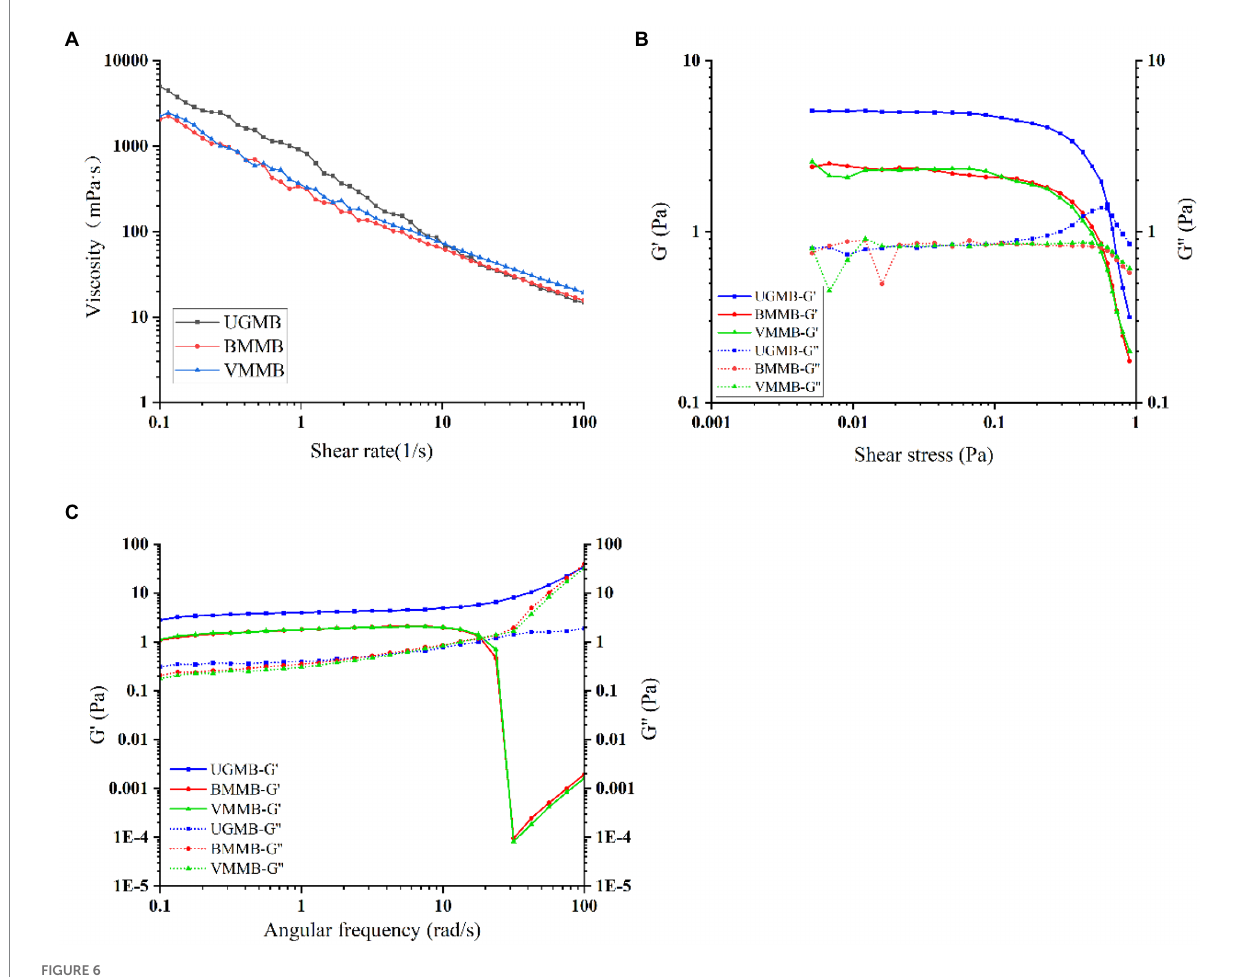
FIGURE 6 Rheological curve of mung bean